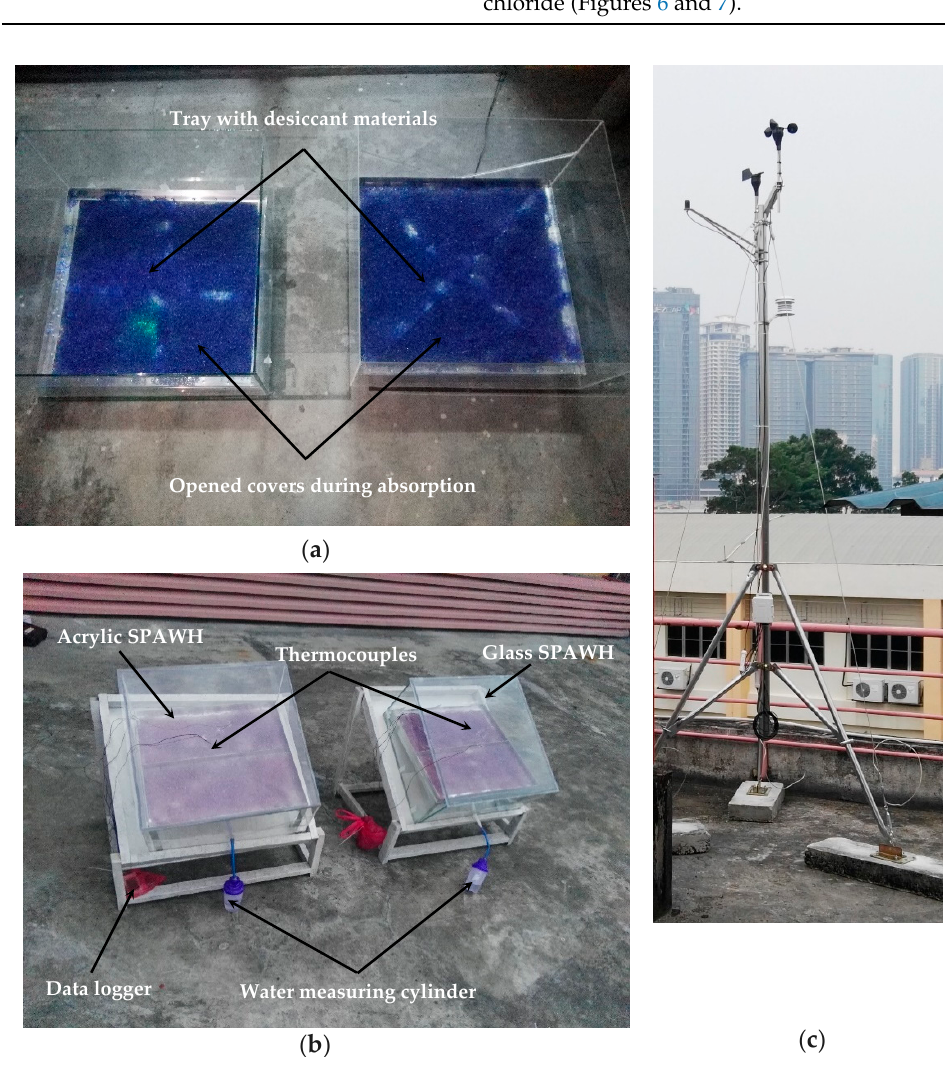
Figure 6. Experimental setup photograph: ( a ) absorption process during the night; ( b ) regeneration process during day and ( c ) Mini meteorological